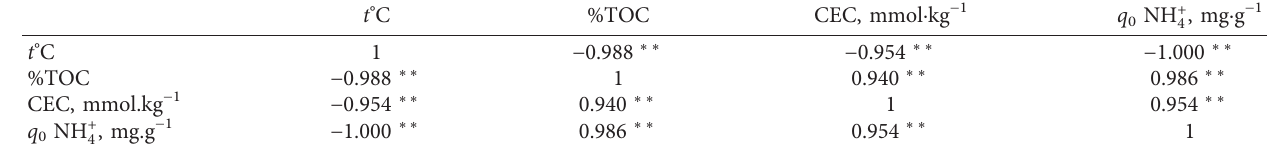
adsorption capacity. 4